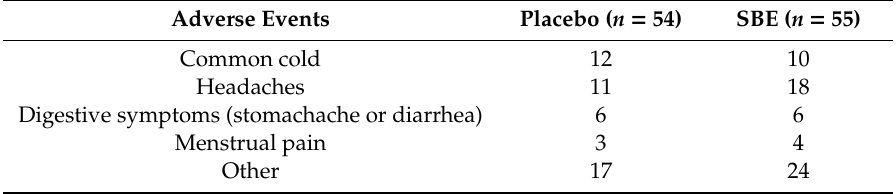
Table 5. Adverse events in the standardized bilberry extract (SBE) and placebo groups. Adverse events